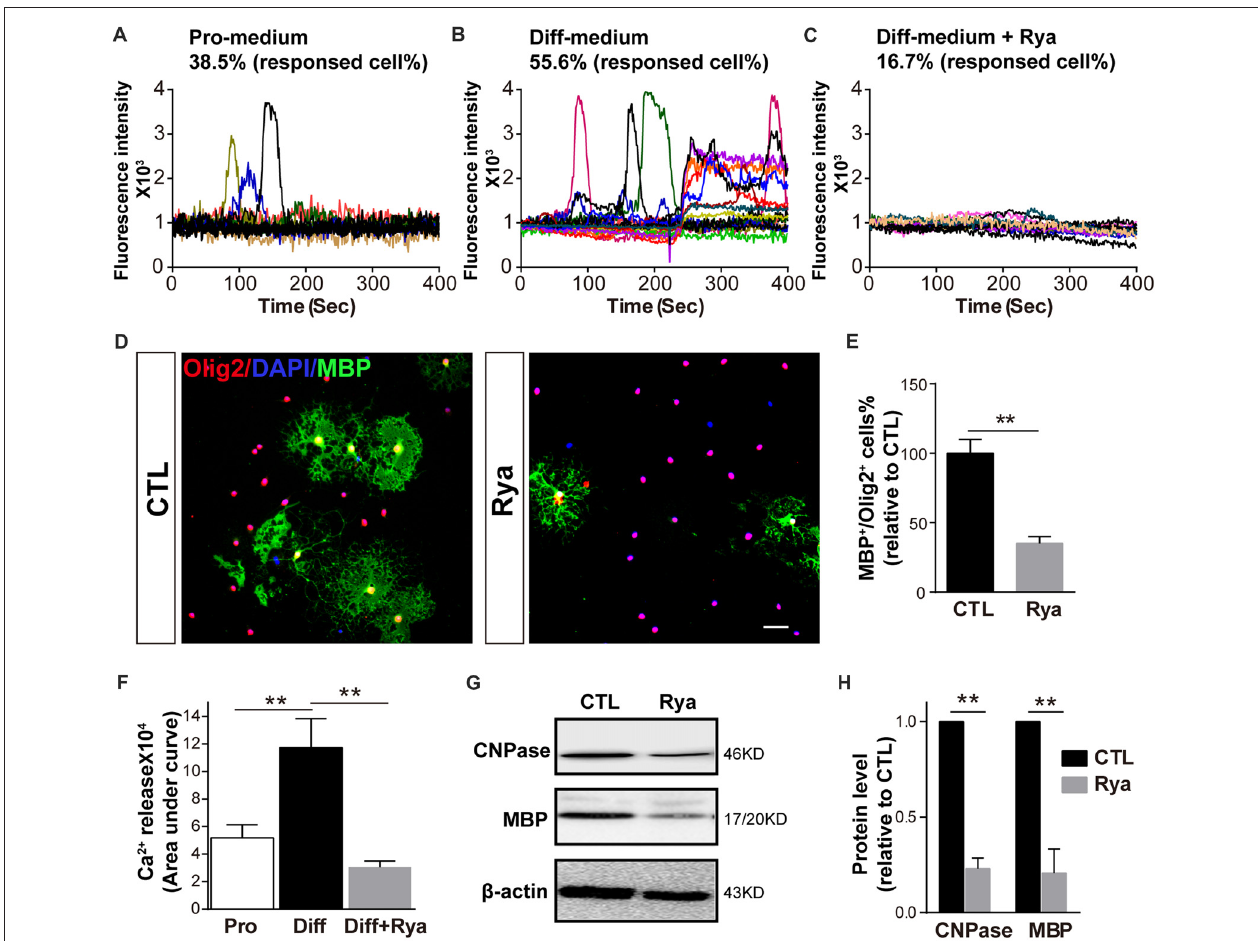
FIGURE 3 | Inhibition of RyR3 by ryanodine suppresses OPC differentiation. (A) Ca 2 + recording of OPCs in proliferation medium (Pro-medium) showing random spontaneous waves. (B) OPCs cultured in differentiation medium (Diff-medium) for 6 h showed frequently higher peak waves, which could be inhibited by ryanodine (Rya) (C) . (F) The total amount of Ca 2 + release, reflected by the area under curve, was greater in early differentiating OPCs than in proliferating OPCs ( ∗∗ p < 0.05), and the release activity in early differentiating OPCs was greatly reduced by ryanodine ( ∗∗ p < 0.05). (D,E) There were fewer MBP-positive mature OLs after treatment with ryanodine (50 µ M) for 72 h. Scale bar 50 µ m. (G,H) Western blot analysis showed the same inhibitory effect of ryanodine on OPC differentiation ( ∗∗ p < 0.05).